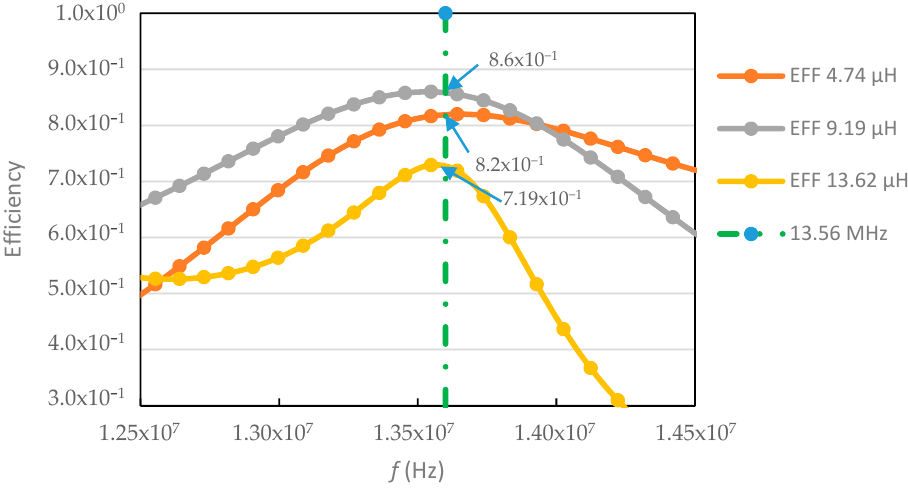
Figure 9. Efficiency in S-CPT with internal resistance of the inductor.